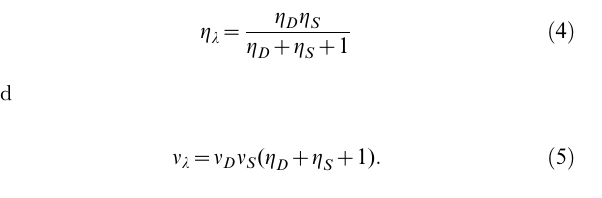
Symbol Description Units (if applicable) Possible